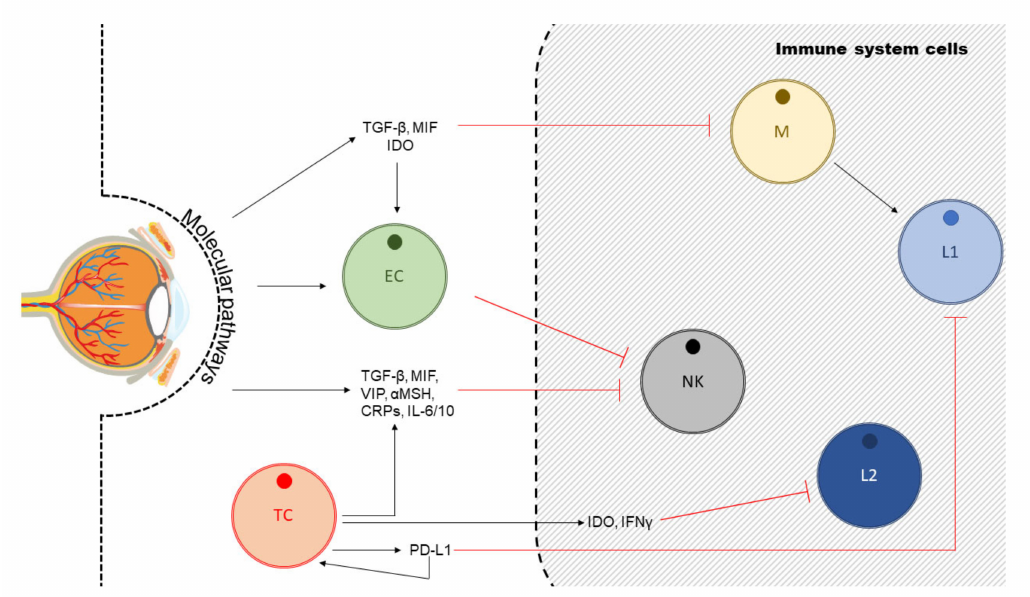
Figure 3. Signalling pathways and interactions between cells in uveal melanoma proliferation. EC, endothelial cells; M, macrophages; L1 T-cells; L2 tumour infiltrating lymphocytes; NK natural killers; red lines inhibition pathways; black lines stimulation